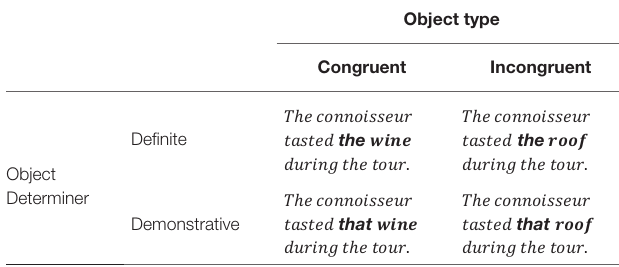
TABLE 1 | Critical conditions with example